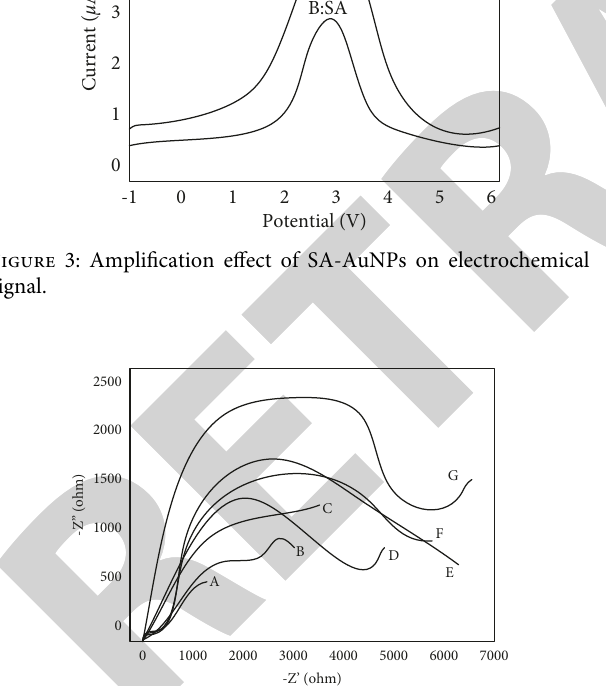
Figure 4: Electrochemical impedance spectroscopy during the electrode surface modification process.